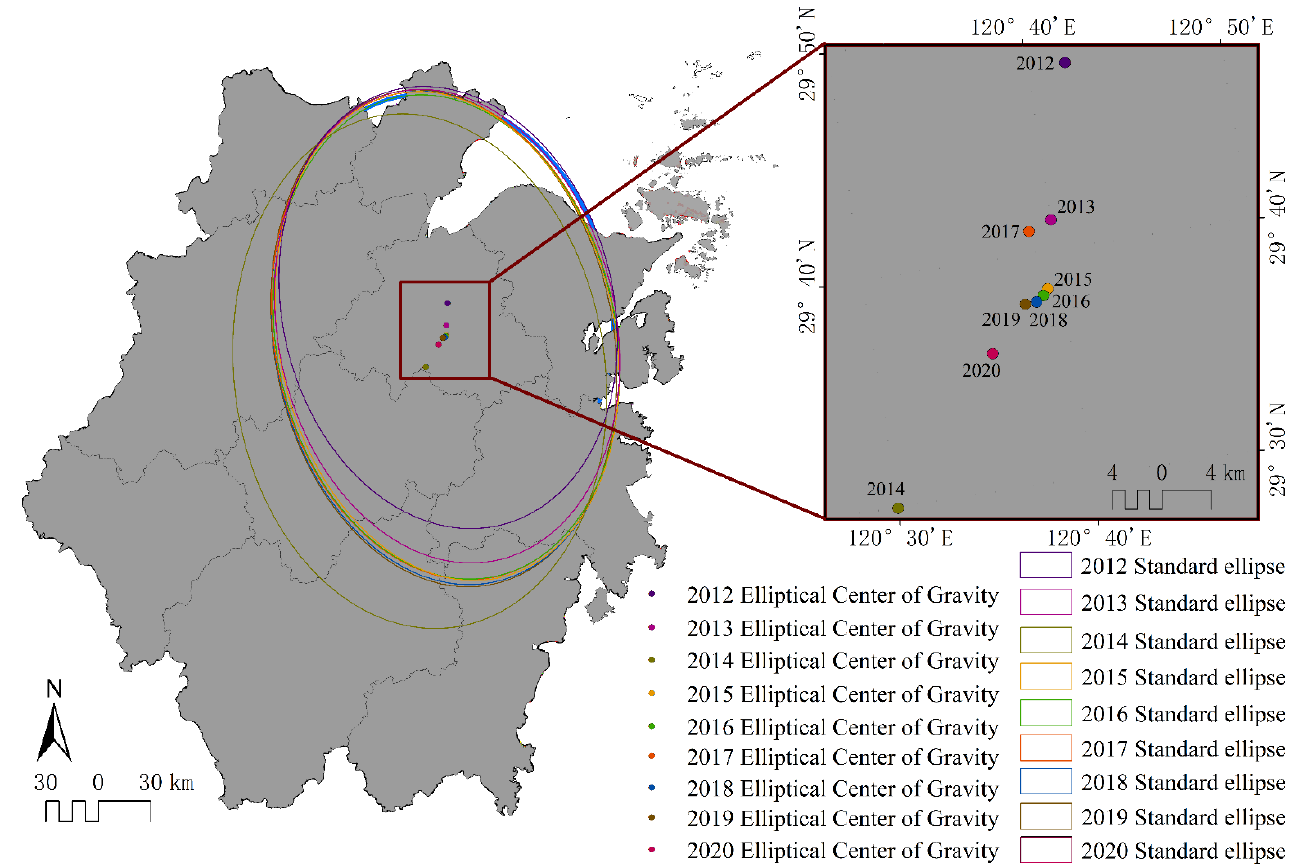
Figure 6. Standard deviation ellipse and center of gravity changes corresponding to the total nighttime light values in Zhejiang Province from 2012 to 2020.